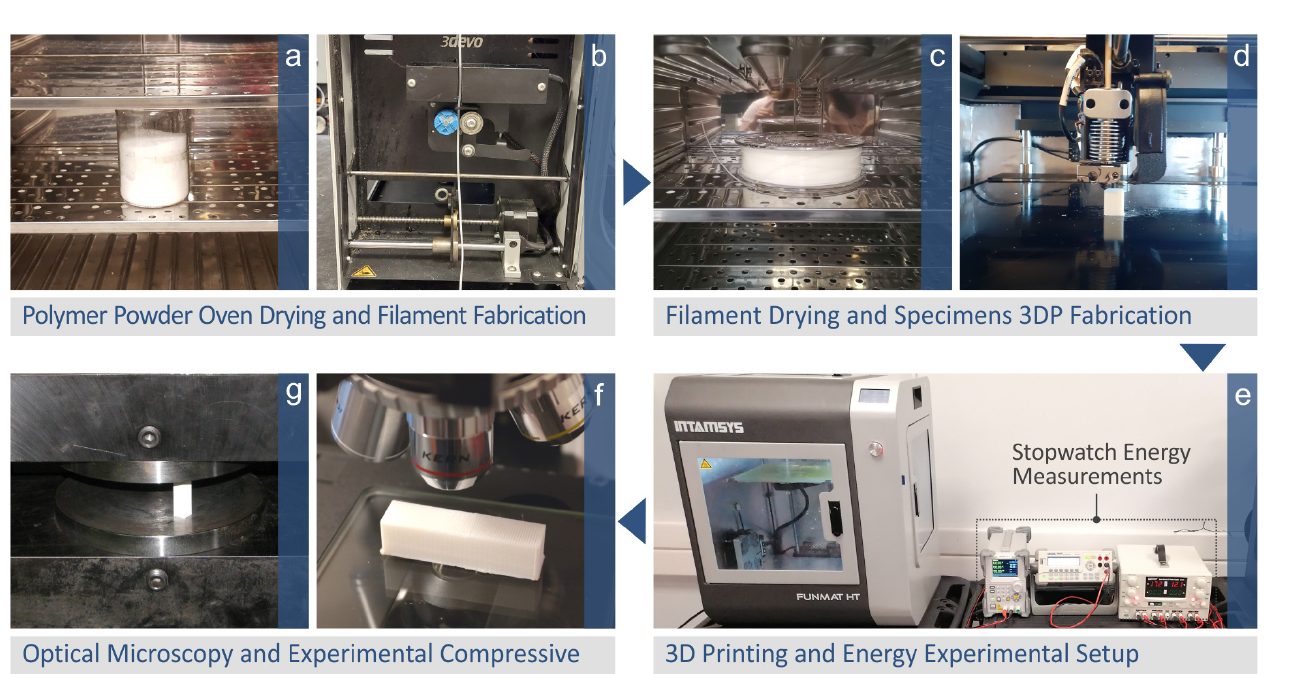
Figure 1. The experimental procedure followed in this work: ( a ) raw materials drying, ( b ) filament extrusion, ( c ) filament drying, ( d ) 3D printing of the samples, ( e ) energy monitoring during the 3D printing process, ( f ) sample inspection in the microscope, ( g ) compression test of the 3D printing samples.